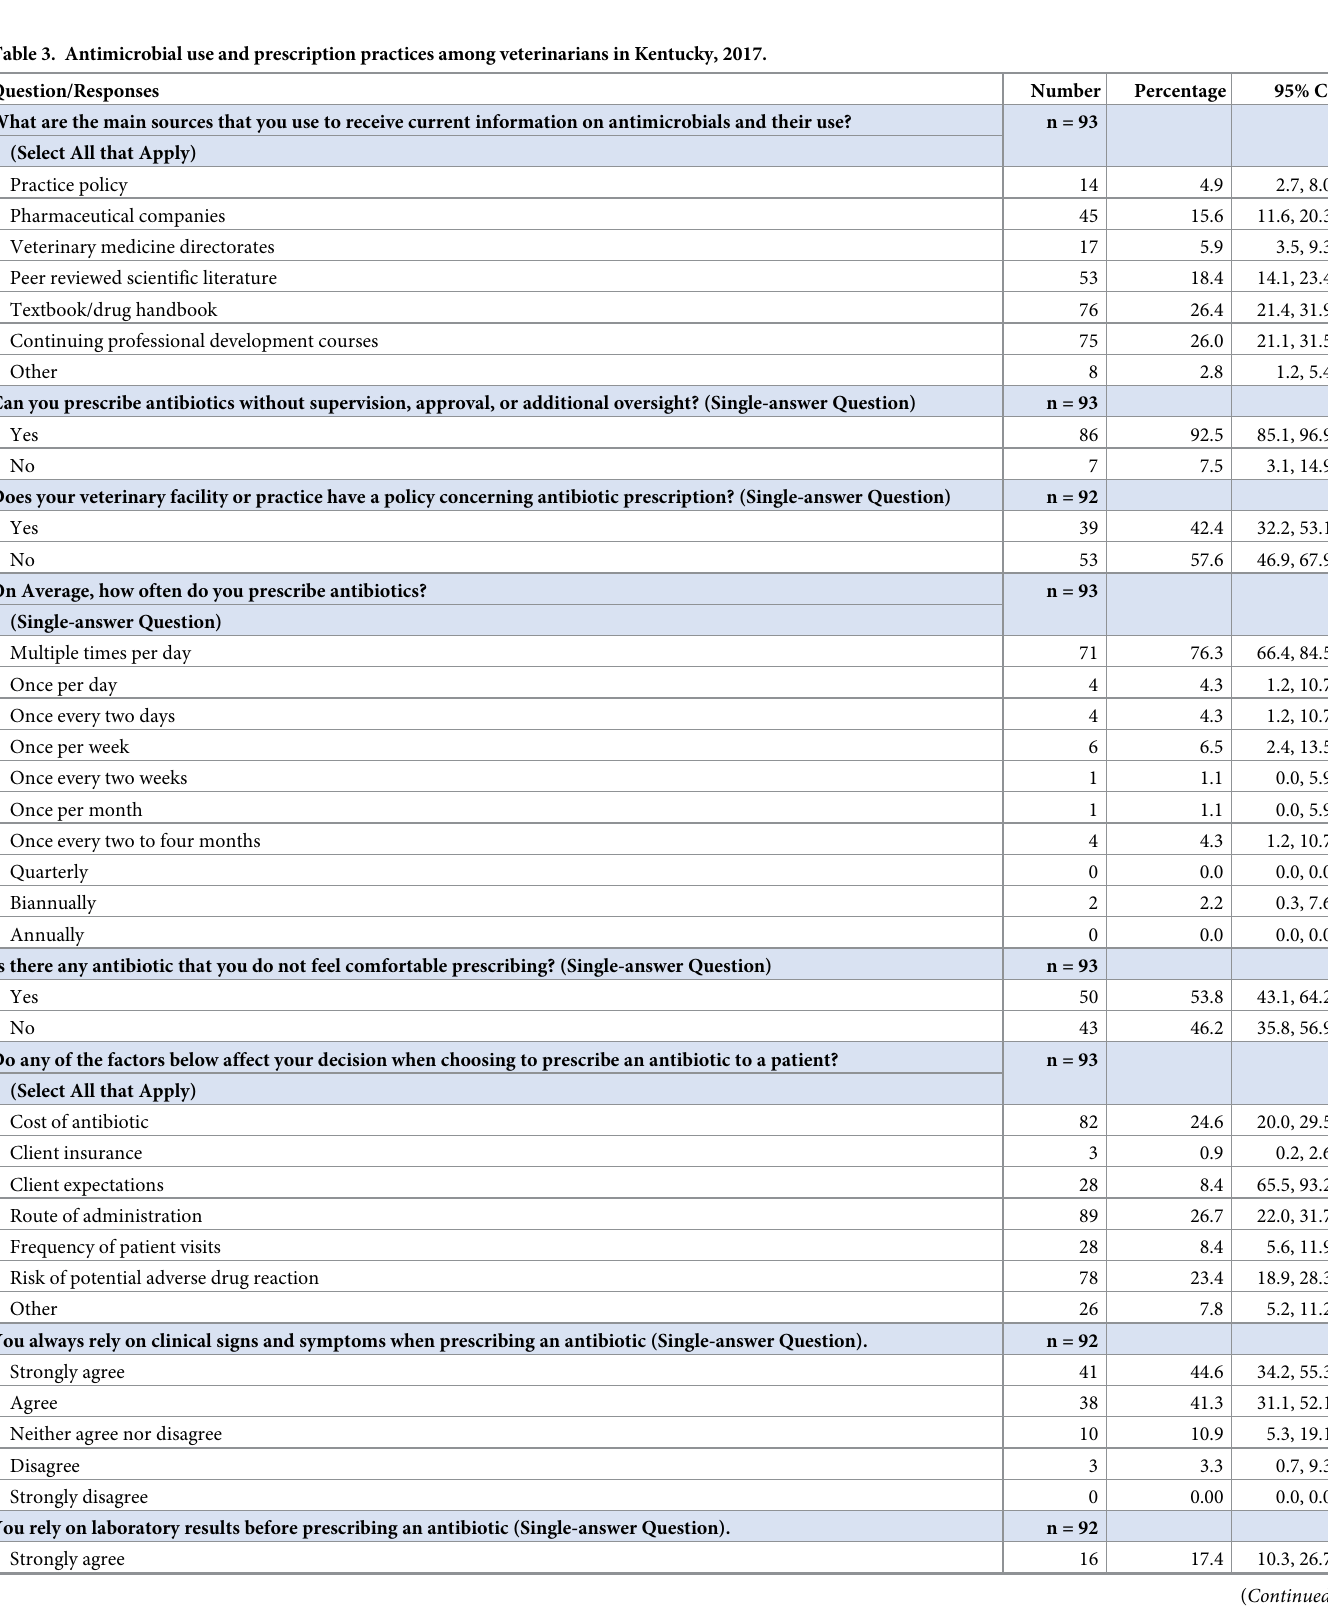
Table 3. Antimicrobial use and prescription practices among veterinarians in Kentucky,